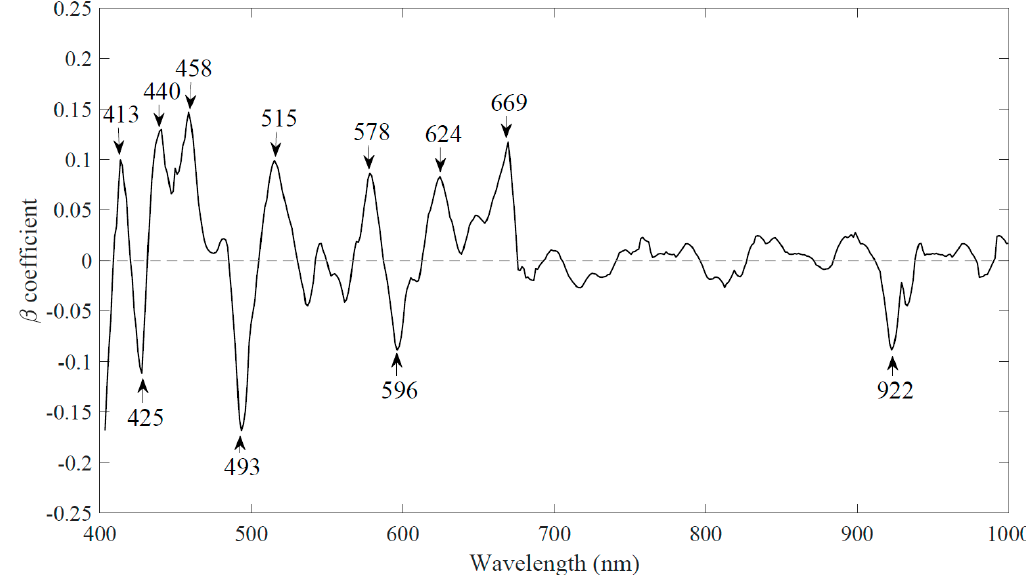
Figure 6. Selection of eleven wavelengths from the weighted regression coefficient method.